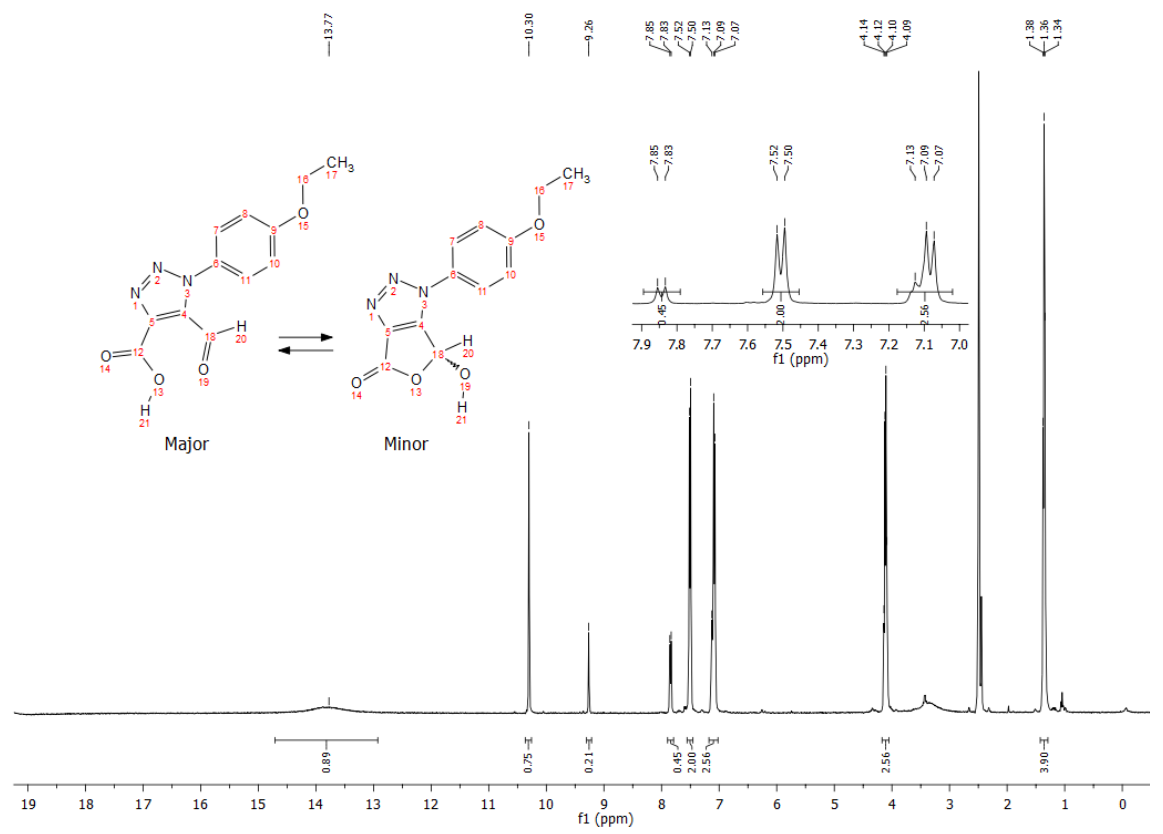
Figure 1. 1 H NMR spectrum of 1-(4-ethoxyphenyl)-5-formyl-1 H -1,2,3-triazole-4-carboxylic acid